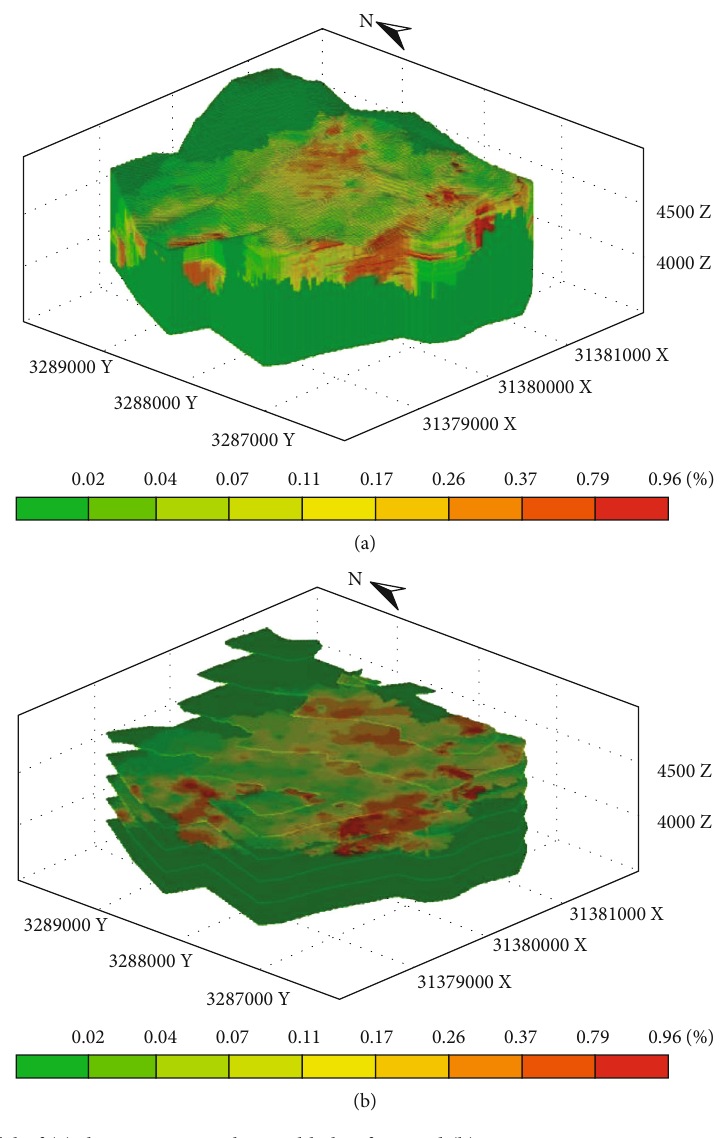
Figure 2: 3D model of (a) the primary geochemical halo of Cu and (b) its cross-section cuttings in the Jiama